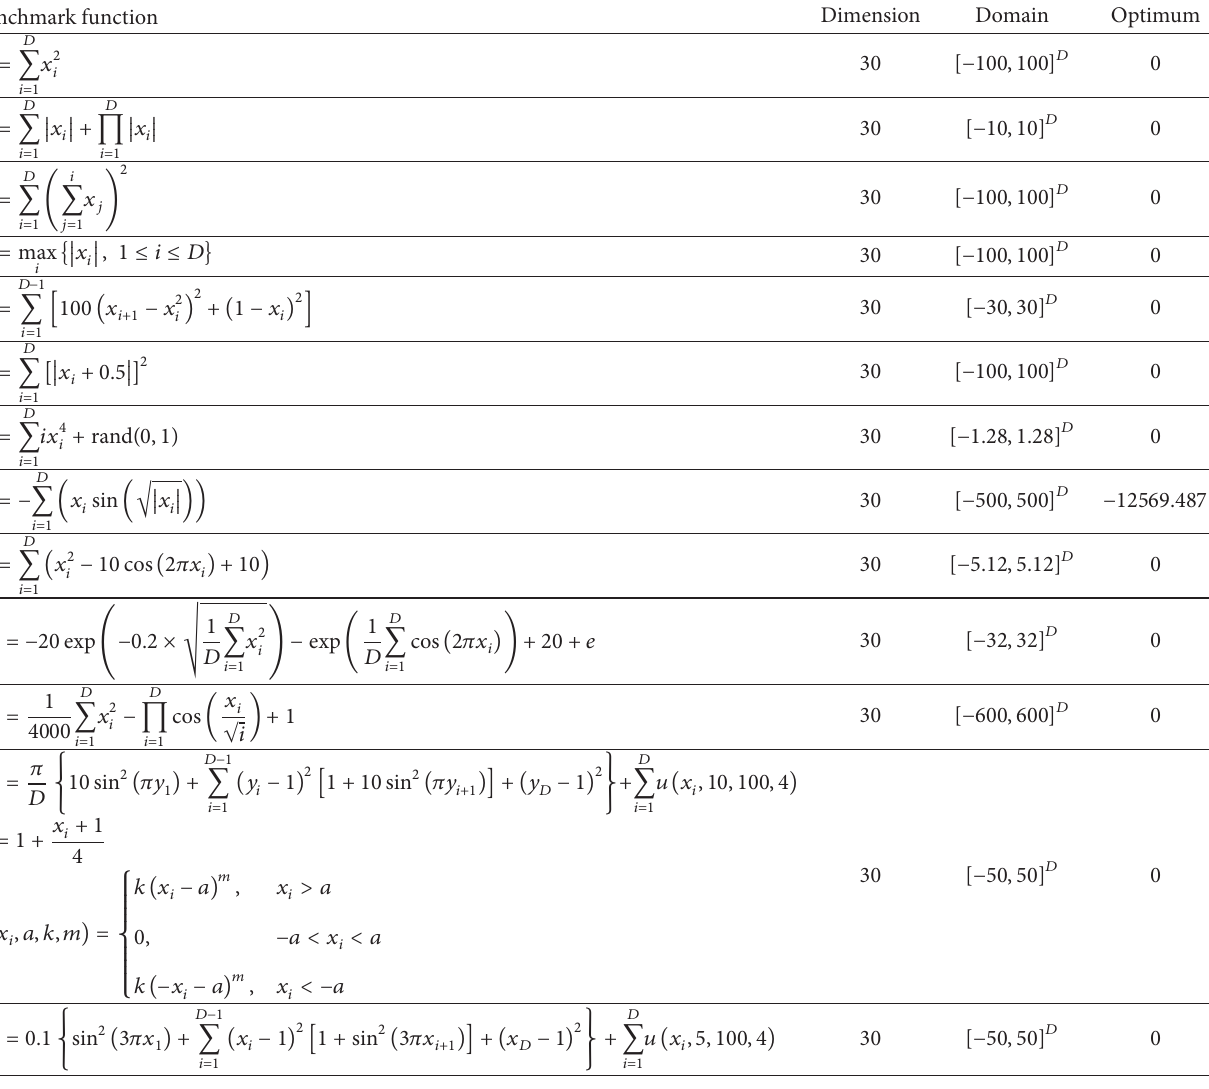
Table 1: Benchmark functions.